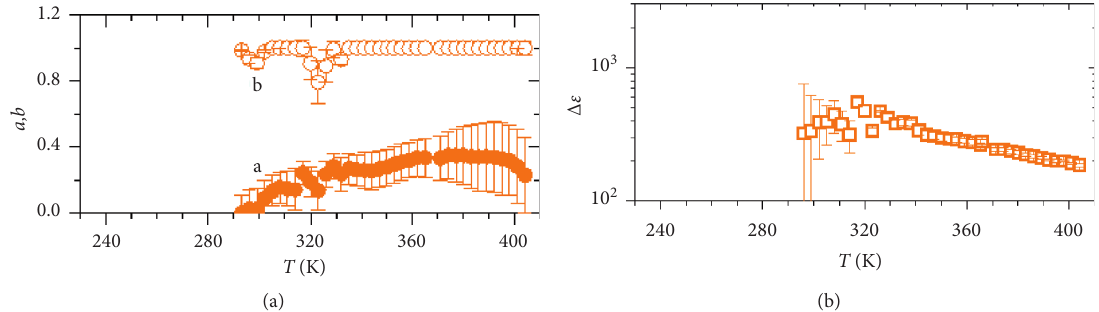
Figure 12: Temperature dependence of the (a) shape parameter and (b) relaxation strength for the MWS relaxation spectra.